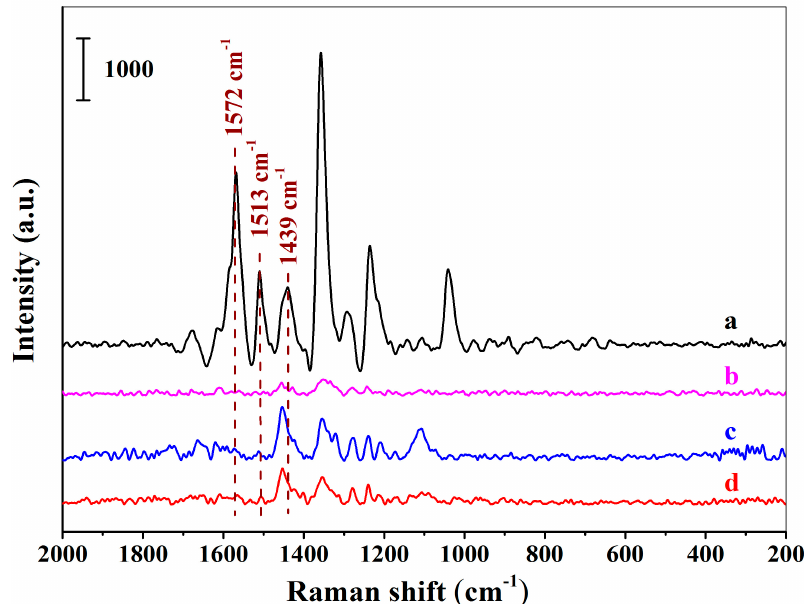
Figure 5. The SERS spectra acquired using the positively charged Au NPs-embedded MIHs as substrates after the MIHs were respectively incubated with the solutions of New Red ( a ), Erythrosine B sodium ( b ), Amaranth ( c ), and Allure Red ( d ) for 2 h at the concentration of 1.64 × 10 − 5